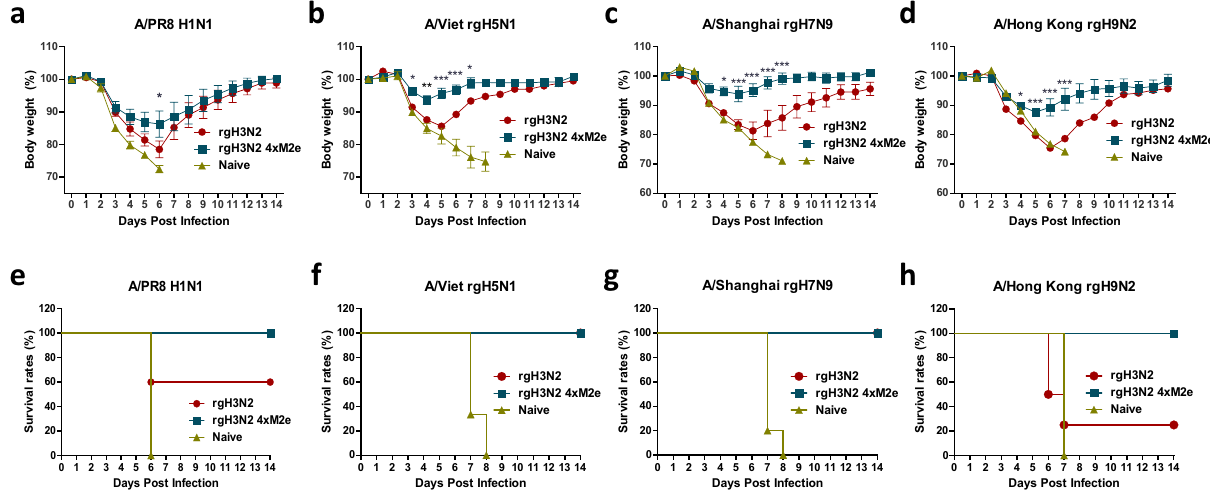
Figure 3. A single dose of live rgH3N2 4xM2e virus provides enhanced heterosubtypic cross protection against different subtype influenza A viruses. Weight changes and survival rates in primed mice after challenge with ( a , e ) H1N1 A/PR8 (3 LD 50 ), ( b , f ) rgH5N1 A/Vietnam (5 LD 50 ), ( c , g ) rgH7N9 virus (reassortant A/ Shanghai, 6 LD 50 ) and ( d , h ) rgH9N2 virus (reassortant A/Hong Kong, 20 LD 50 ). Differential challenge doses were used depending on the pathogenicity and HA phylogenic distance of virus. Groups of mice (n = 5 or 6) were intranasally primed with rgH3N2 (10 5 EID 50 ) or rgH3N2 4xM2e (10 5 EID 50 ) and then challenged 3 weeks later. Two independent repeat of mouse challenge experiments confirms the reproducibility of data. rgH3N2: 6:2 reassortant with WT HA and NA of A/Switzerland/2013. rgH3N2 4xM2e: 6:2 reassortant with 4XM2e-HA and NA of A/Switzerland/2013. Each individual mouse animal is analyzed. Error bars show mean ± SEM. The statistical significances between rgH3N2 group versus rgH3N2 4xM2e group were determined using two-way ANOVA and indicated in *, P < 0.05; **, P < 0.01; ***, P < extra 2 × hM2e in the rgH3N2 4xM2e construct. Both rgH3N2 and rgH3N2 4xM2e immunized groups showed similarly high levels of IgG isotype antibodies specific for H3N2 virus (Fig. 2c,d). Both sera from rgH3N2 and rgH3N2 4xM2e immune mice exhibited vaccine strain specific HAI activities against rgH3N2 (A/Switzerland) virus (Fig. 2e) but not against A/PR8 (H1N1), A/Philippines (A/Phil H3N2) and A/Vietnam (A/Viet rgH5N1). Therefore, prime dose of live rgH3N2 4xM2e but not rgH3N2 virus could induce M2e specific IgG isotype anti- bodies in mice. Prime dose of live rgH3N2 4xM2e vaccination provides broad cross protection. Intranasally prime vaccinated mice with 10 5 EID 50 of rgH3N2 or rgH3N2 4xM2e were challenged with different subtype influenza viruses including H1N1 (A/PR8), rgPR8 with avian M2 (rgPR8 Mm, rgPR8 Mg), H3N2 (A/Phil), rgH5N1 (A/Viet), rgH7N9 (A/Shanghai), and rgH9N2 (A/Hong Kong). The rgH3N2 4xM2e group showed higher survival rates (100%) and a trend of less weight loss against A/PR8 challenge, compared to the rgH3N2 group with 60% survival rates (Fig. 3a,e). Next, we tested PR8 reassortants containing avian M2 (rgPR8 Mm, rgPR8 Mg, Supplementary Fig. S4a, b, d, e) as a challenge virus, following single-dose vaccination with rgH3N2 or rgH3N2 4xM2e. A trend of less weight loss against rgPR8 Mm (M gene from A/Mandarin duck/Korea/ PSC24-24/2010, H5N1) or rgPR8 Mg (M gene from A/Chicken/Korea/Gimje/2008, H5N1) was observed in the rgH3N2 4xM2e group, compared to those in the rgH3N2 control group. When challenged with a wild type 2009 H1N1 pandemic A/California/04/09 virus containing swine M2, the rgH3N2 4xM2e primed mice showed a pat- tern of less weight loss and quicker recovery than the rgH3N2 group (Supplementary Fig. S5). However, these difference between these two groups were not statistically significant. To test the breadth of cross protection, different subtypes of PR8 reassortants were used as a challenge virus. The rgH3N2 4xM2e primed mice exhibited significantly less weight loss (~ 5%) than rgH3N2 primed mice (~ 16%) at day 5 after challenge with rgH5N1 (Fig. 3b,f). Similarly, when challenged with rgH7N9 virus, the rgH3N2 4xM2e group displayed average weight loss 6% compared to 19% weight loss in rgH3N2 prime mice and the mock control with over 20% weight loss and 0% survival rates (Fig. 3c,g). After a high lethal dose (100 LD 50 ) challenge with rgH9N2 virus, rgH3N2 4xM2e primed mice showed 75% survival protection whereas rgH3N2 immune and mock control mice all died of infection (Supplementary Fig. S4c, f). When challenged with rgH9N2 at 20 LD 50 dose, rgH3N2 4xM2e primed mice showed better protection as evidenced by significantly preventing weight loss (average 11% day 6) and enhancing survival rates than rgH3N2 immune mice displaying 25% weight loss (day 6) and 25% survival rates (Fig. 3d,h). After challenge with A/Phil (H3N2), 3% weight loss was observed with rgH3N2 4xM2e primed mice in contrast to 12% weight loss was observed with rgH3N2 primed mice (Fig. 4a). Collectively, these results suggest that single dose intranasal priming of mice with rgH3N2 4xM2e could provide enhanced cross protection against diverse subtypes of influenza A viruses containing human or avian M2.